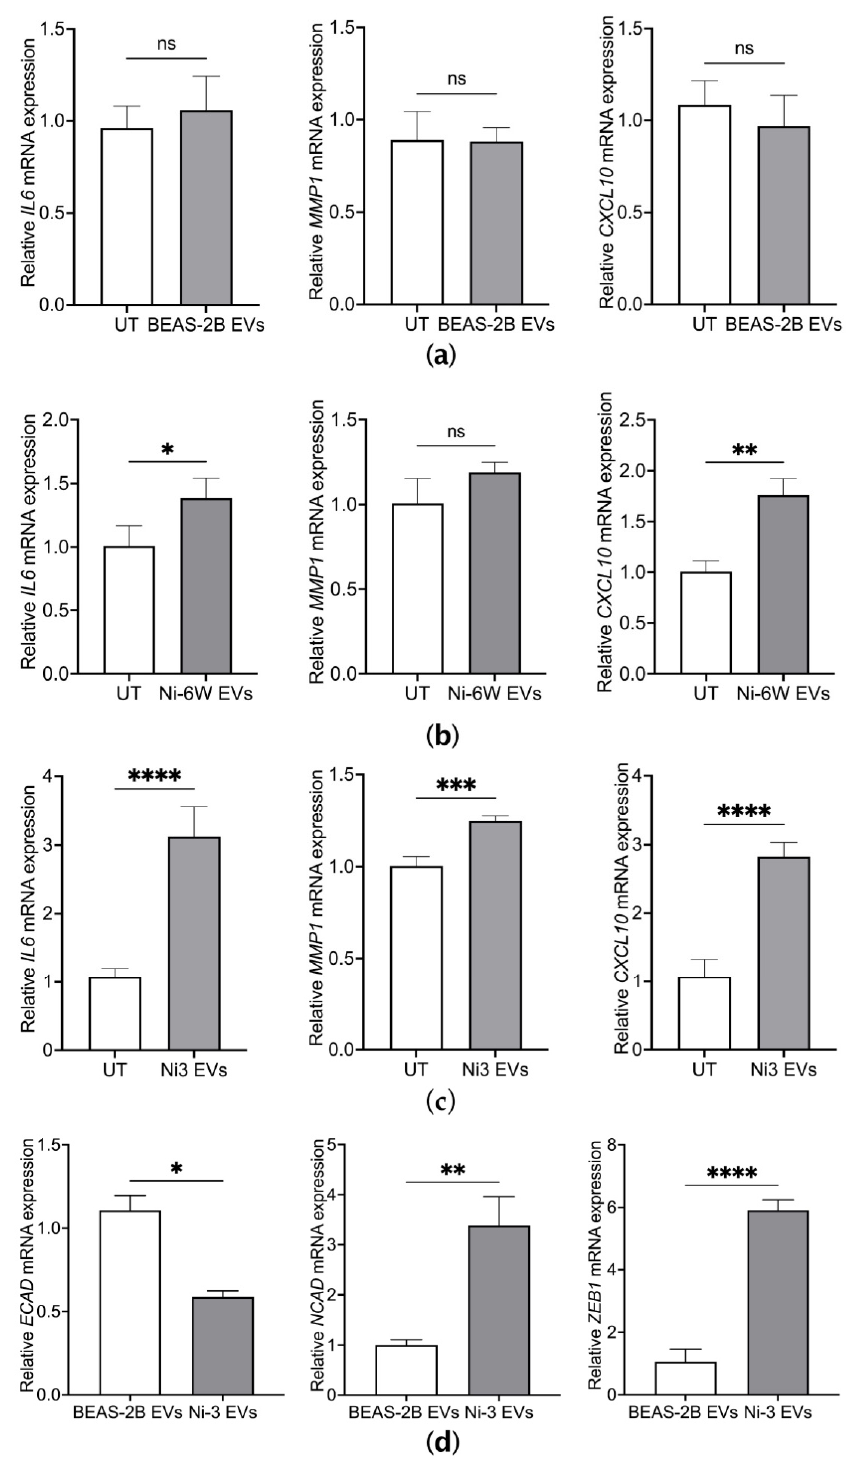
Figure 3. EVs from Ni-transformed cells induced the mRNA expression of inflammatory markers and EMT markers in BEAS-2B cells. The mRNA expression of inflammatory markers including IL6, MMP1, and CXCL10 were measured by quantitative real-time PCR after BEAS-2B cells were treated for 4 h with 10 µ g/mL of EVs from BEAS-2B ( a ), Ni-6W ( b ), and Ni-3 cells ( c ). The mRNA expression levels of EMT markers were measured after 2 weeks of treatment with 5 µ g/mL of Ni-3 EVs in BEAS-2B cells ( d ). Values are presented as mean ± SEM. ns: no significance, * p < 0.05, ** p < 0.01, *** p < 0.001, and **** p <